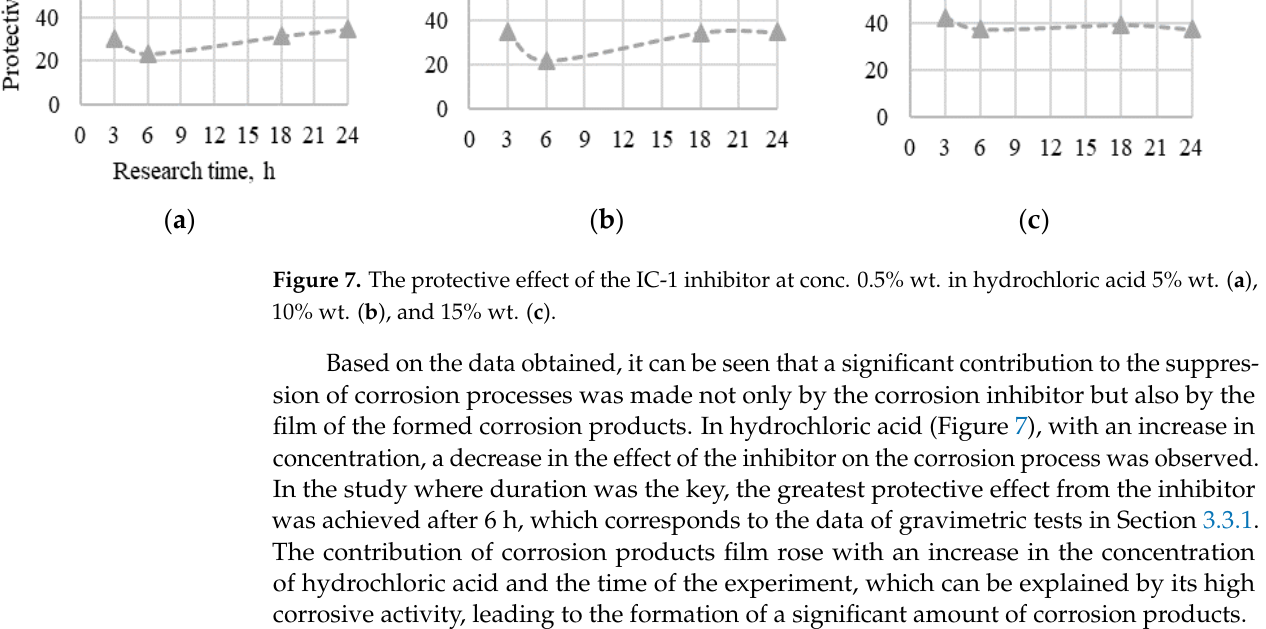
( с ) Figure 8. The protective effect of the IC-2 inhibitor at conc. 0.4% wt. in sulfamic acid 5% wt. ( a ), 10% wt. ( b ), and 15% wt. ( c ). When studying the corrosion process in sulfamic acid using Figure 8, it can be seen that with an increase in the acid concentration, the activity of the inhibitor increased and, accordingly, its contribution to the protective effect. The protective effect of the inhibitor itself increased over time and reached its maximum value after 24 h. The contribution of the reaction products formed during corrosion decreased with a growth in the concentra- tion of sulfamic acid and the duration of the experiment. Thus, taking into consideration